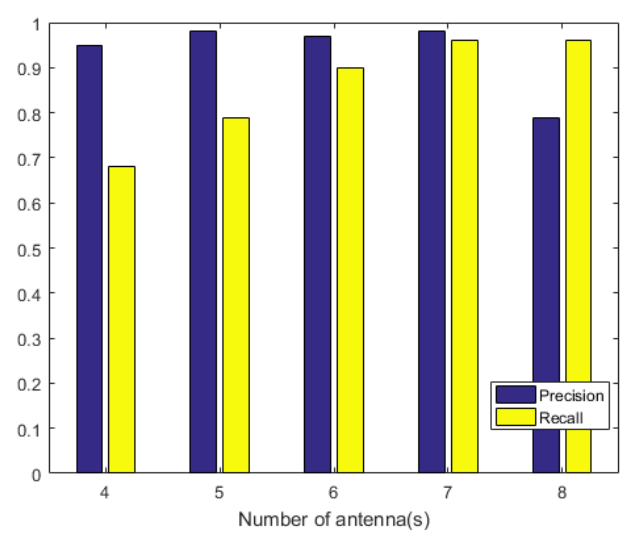
Figure 7. Impact of the number of antennas on the precision and recall.